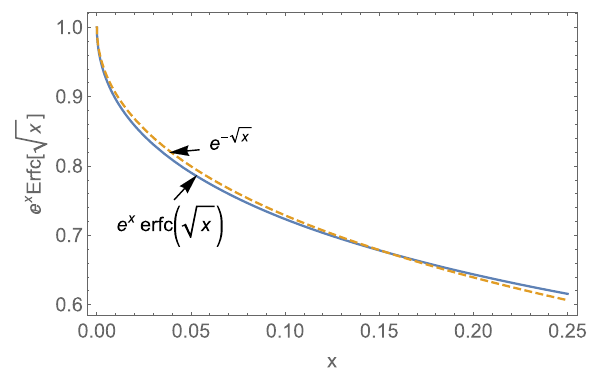
ffiffiffi p Þ (blue solid), and the approxi- x